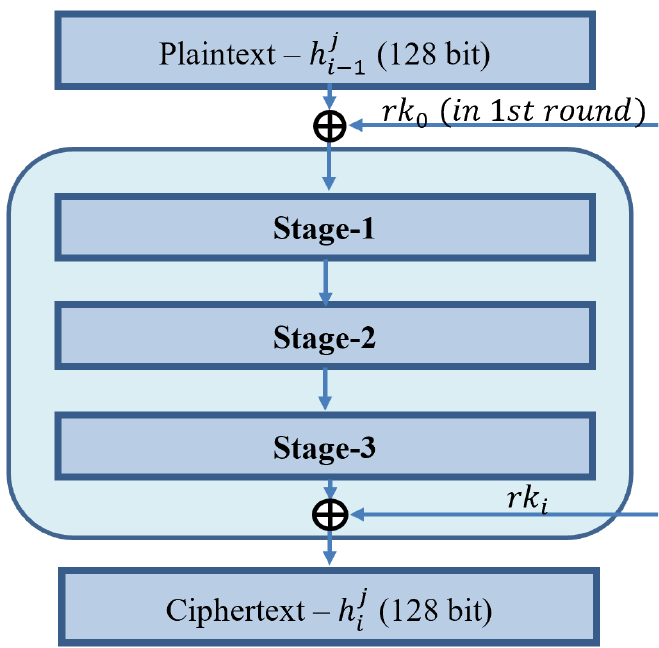
Figure 2. Scheme for the CF algorithm.